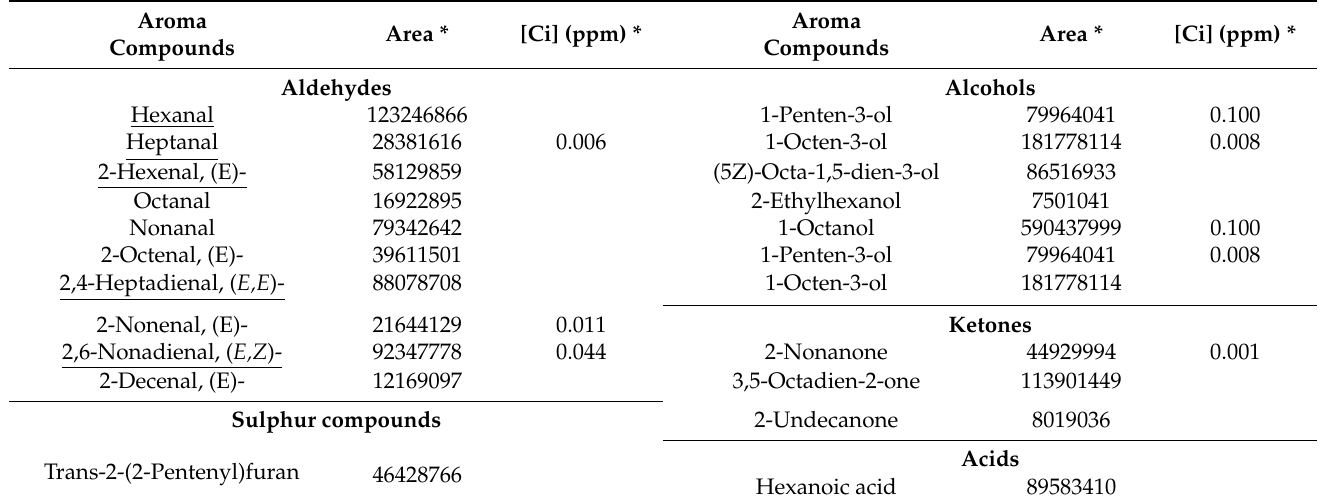
Table 1. Aroma compounds identified in Sardine cooking wastewaters.